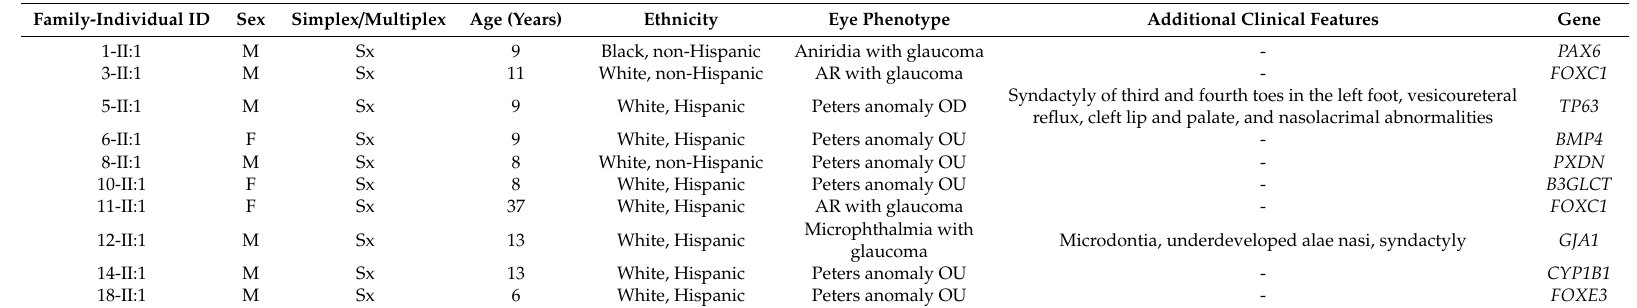
Table 2. Phenotypic features of probands with causative